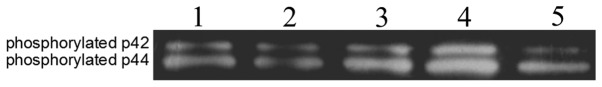
Influence of the different concentration Res on the expression of phosphorylated p42/44 ERK in AA synoviocytes. Lane 1, AA model group; lanes 2–4, stimulated by Res (0.5, 5 and 50 mg/l, respectively); lane 5, chelerythrine and 5 mg/l Res. AA, adjuvant arthritis; Res, resveratrol.